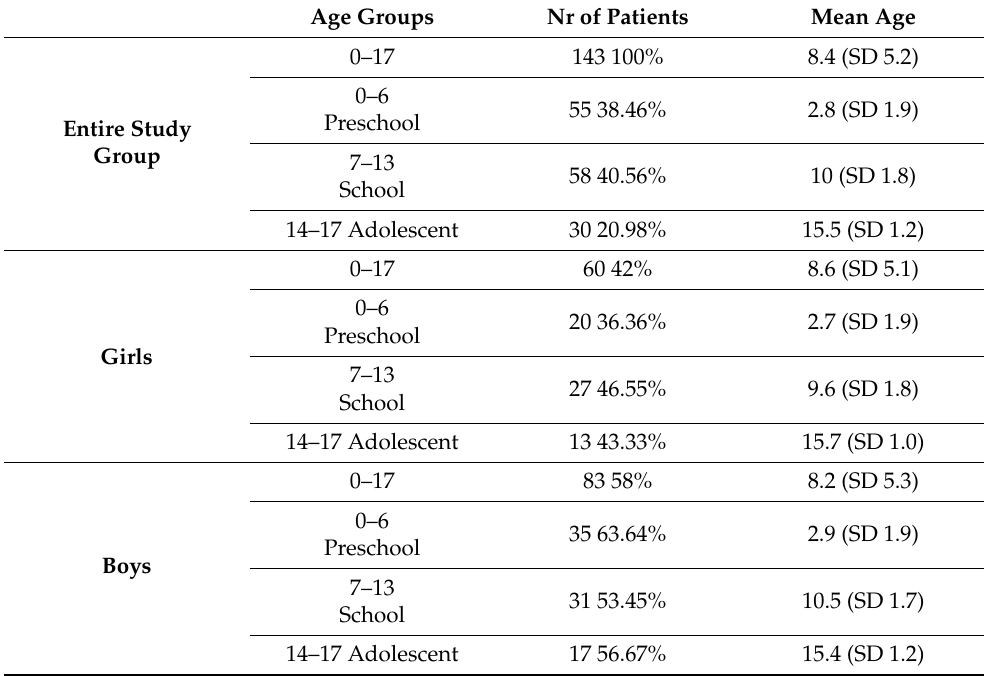
Table 1. Total sample